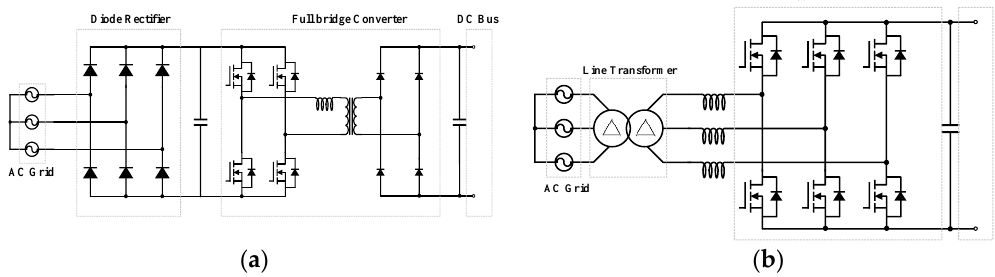
Figure 2. Conventional topologies: ( a ) diode rectifier and full-bridge DC-DC converter, ( b ) boost-type AC-DC rectifier with line transformer.